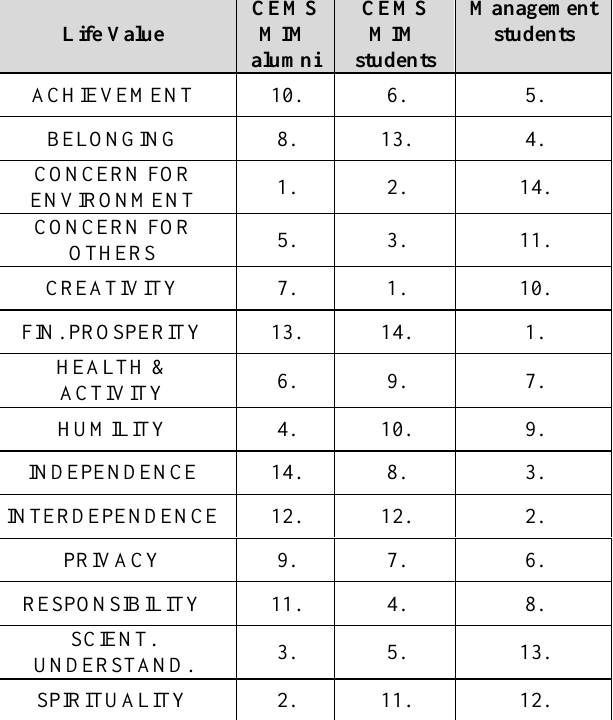
Table 2: Life Values